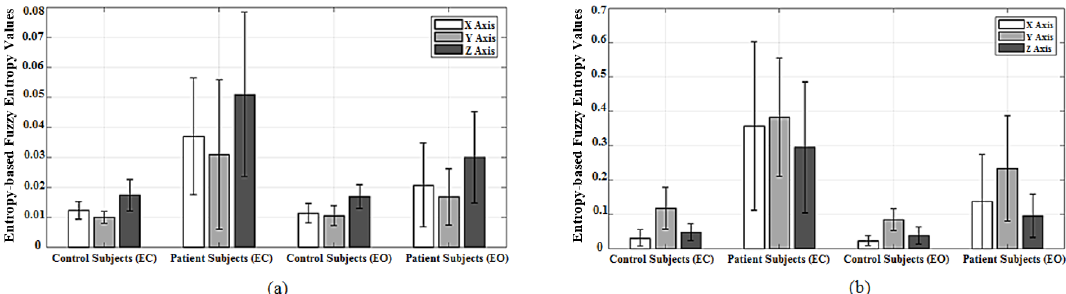
Figure 4. Bar-graphs represent mean and standard deviation values of velocity-based Fuzzy entropy values of Romberg test using two sensors which ( a ) is Sensor 1 and ( b ) is Sensor 2.